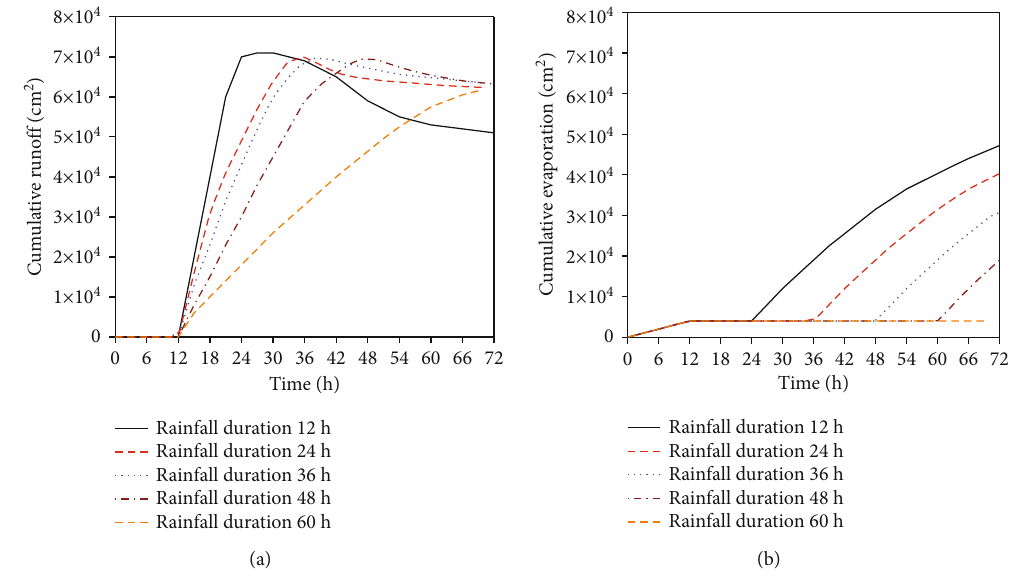
Figure 9: Cumulative runo ff and cumulative evaporation for the rainfall amount of 500 mm at di ff erent times: (a) cumulative runo ff and (b) cumulative